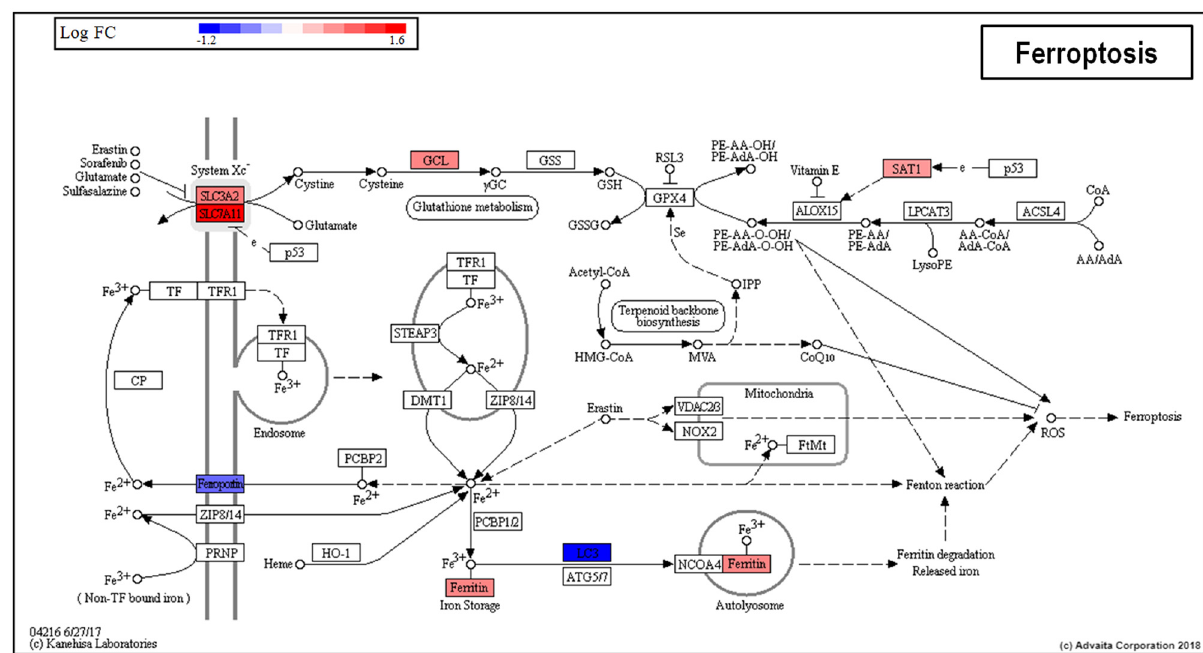
Figure 4: Compound 1 signi fi cantly impacts the expression of targets within ferroptosis pathway. iPathwayGuide online software was used to perform the impact analysis. ( a ) The di ff erence in mRNA expression between HT - 29 cells treated with compound 1 ( 1.73 μ M ) or vehicle ( control ) are shown with a heat map at the top left displayed as Log2 fold change ( LogFC ) . Blue indicates down - regulated genes and red indicates up - regulated genes ( log2 ǀ ( fold change ) ǀ ≥ 0.5, p - value ≤ 0.001, and q - value ≤ 0.05 )